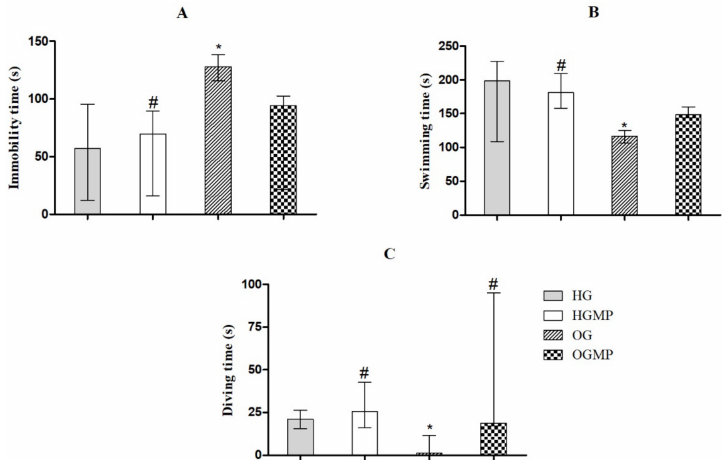
Figure 5. Results of the forced swim test regarding the immobility time ( A ), swimming time ( B ) and diving time ( C ) evaluated of healthy and obese rats treated or not with MP seed extract. Data presented as median (minimum and maximum). Kruskal-Wallis test and Dunn post-hoc ( p ≤ 0.05). * di ff ered from HG; # di ff ered from OG.